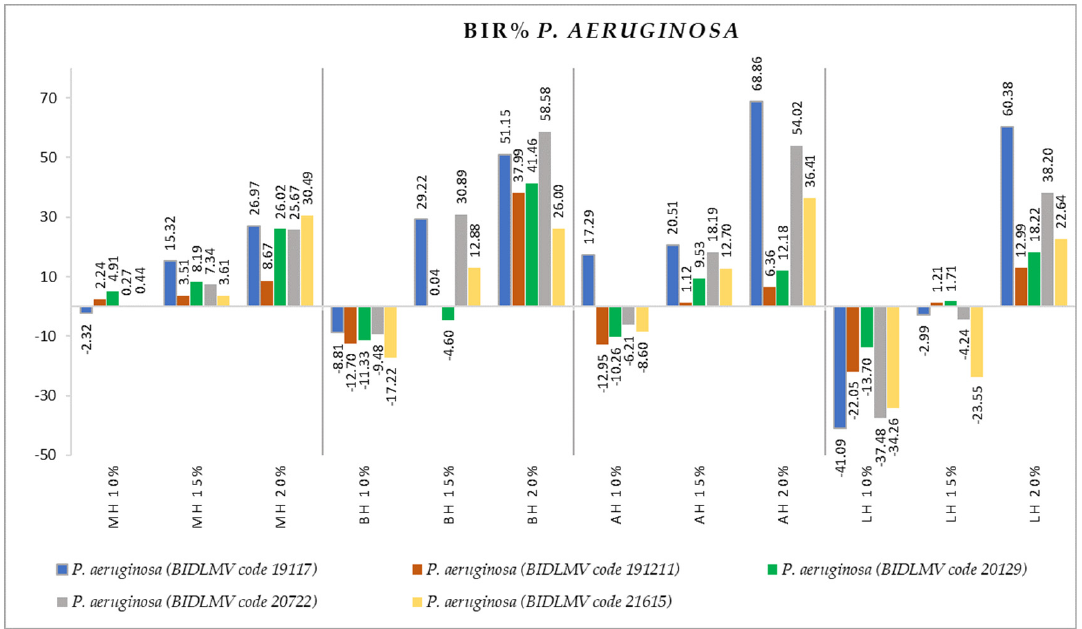
Figure 11. Antimicrobial activity (expressed as BIR%) of honey samples tested on P. aeruginosa isolates. A table containing the BGR%/MGR% values (2) when different concentrations of honey samples were applied to the screened strains is presented in the Supplementary Data: File S1.